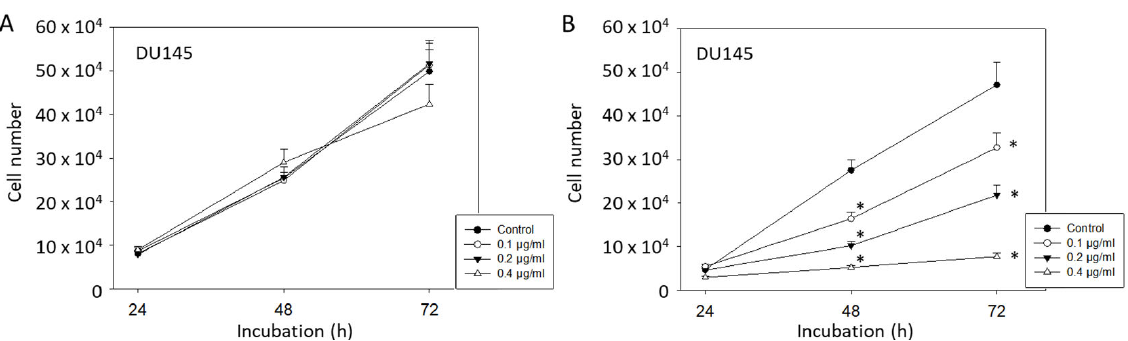
Figure 1. ( A ): Growth of DU145 and PC3 prostate cancer cells without irradiation. Cells were treated with 0.1, 0.2, or 0.4 μ g/mL curcumin and then assessed by MTT assay. Controls remained untreated. ( B ): Growth of DU145 and PC3 prostate cancer cells treated with curcumin and visible light (5 min at 1.65 J/cm 2 ). Controls were irradiated without curcumin. Each experiment was performed in triplicate and repeated 6 times. Data from one representative experiment is shown. Error bars indicate standard deviation; * indicates significant difference to controls. *** related to all 0.1, 0.2, and 0.4 μ g/ml. 2.2. Clonogenic Growth Figure 2, left, depicts morphology of tumor clones after 7 days of incubation. DU145 formed tight clone aggregates when grown in culture medium alone or treated with either visible light (5 min at 1.65 J/cm 2 ) or curcumin (0.2 μ g/mL). Combined treatment induced a distinct loss of cell–cell contact and destruction of clone formation. Similar clone behav ‐ ior was seen with PC3 cells, although the clones were less densely packed. Figure 2, right, shows significant reduction of the cell clone number following tumor treatment with cur ‐ cumin (0.2 μ g/mL) plus irradiation (5 min visible light at 1.65 J/cm 2 ). No effects were ob ‐ served when DU145 or PC3 were treated with curcumin or light